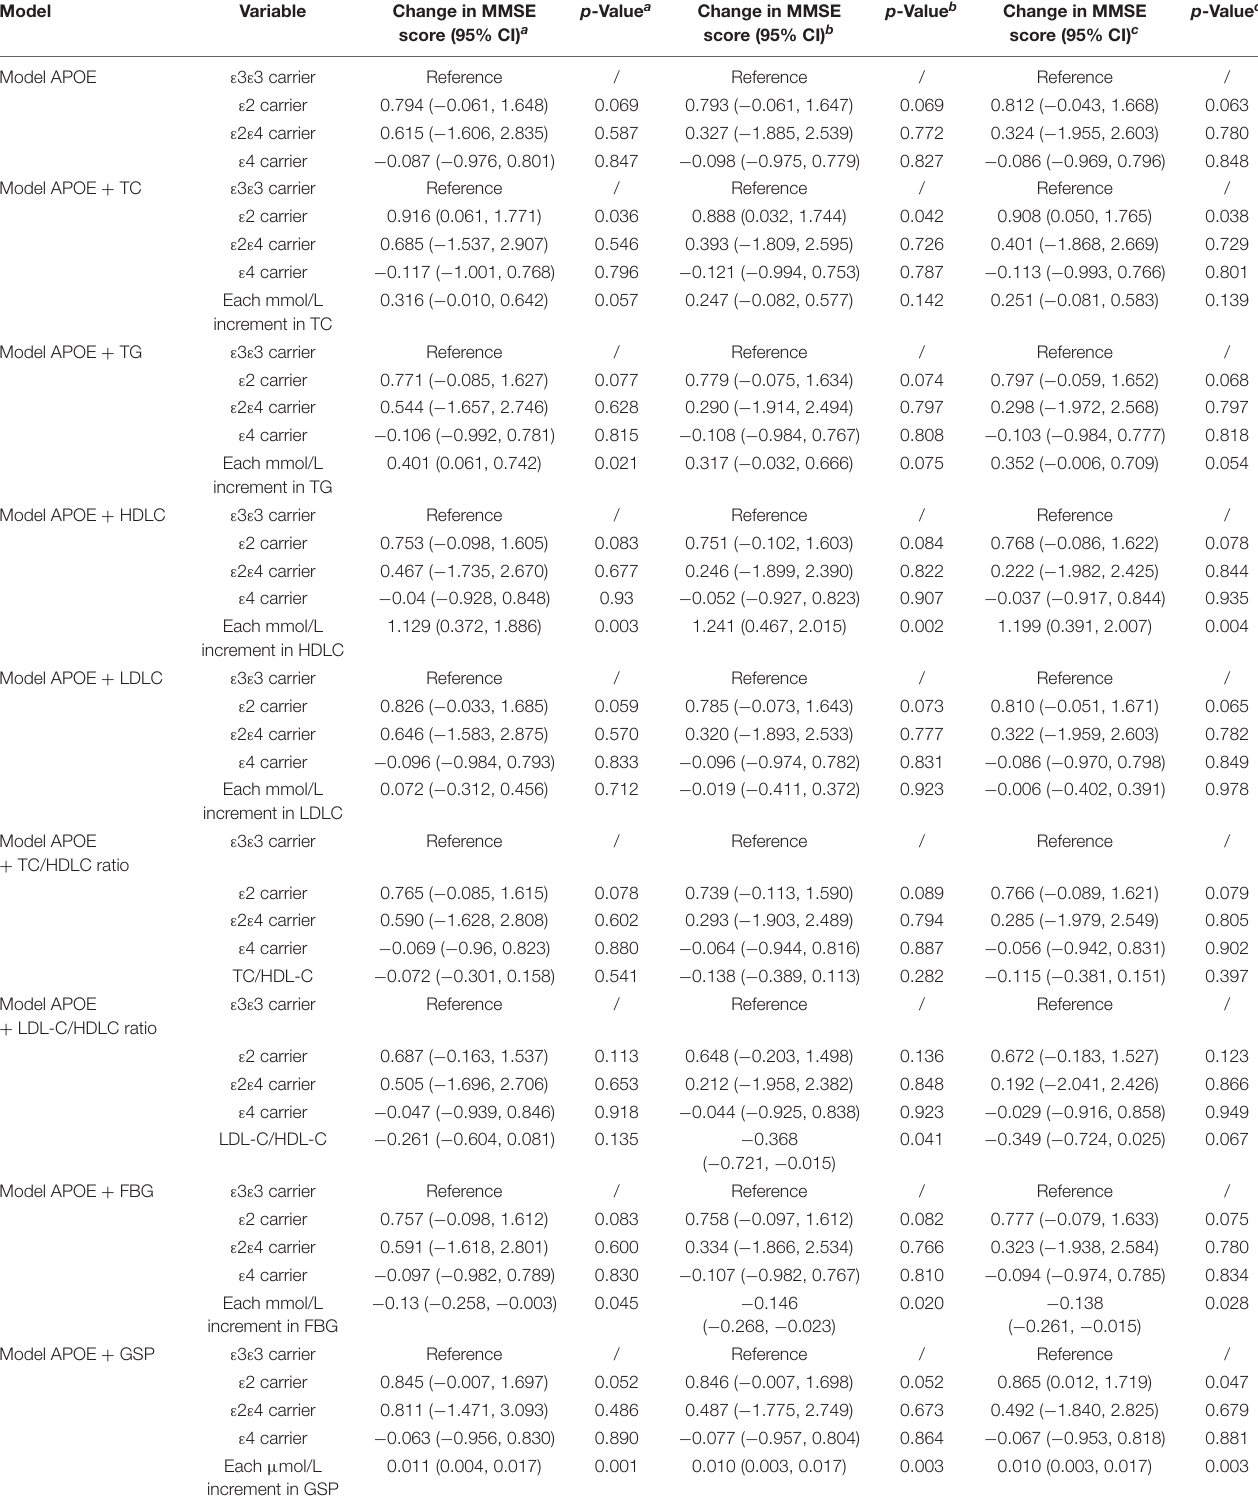
TABLE 4 | The association among APOE , lipids, glucose and cognitive function (MMSE continuous score).